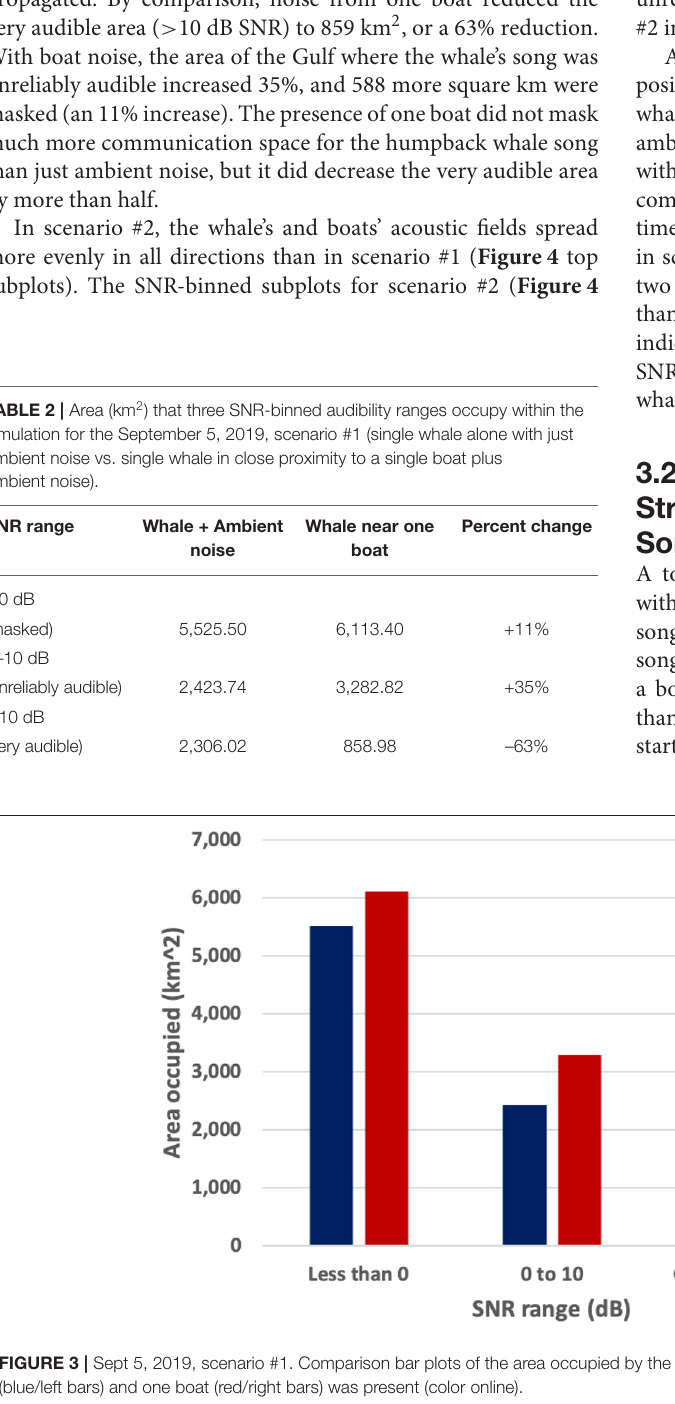
Frontiers in Marine Science |